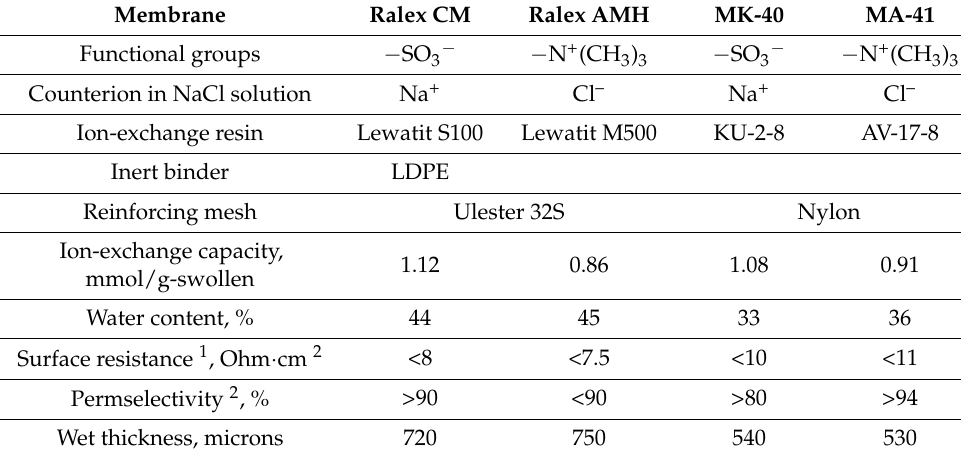
Table 2. Physic-chemical properties of the membranes